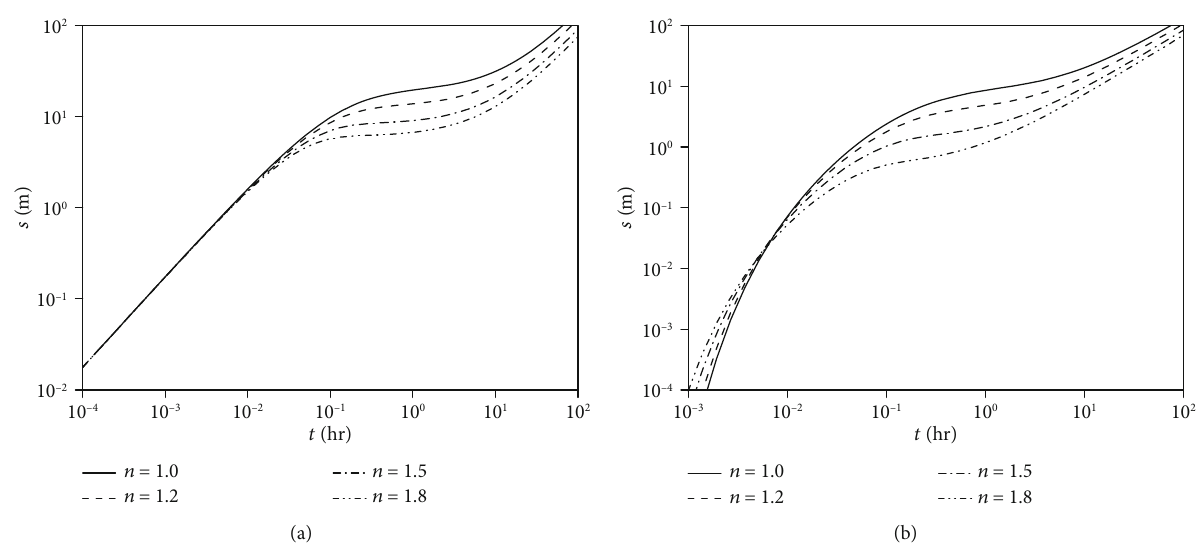
Figure 5: Impact of non-Darcy ( n ) on the drawdown in pumping well (a) and aquifer